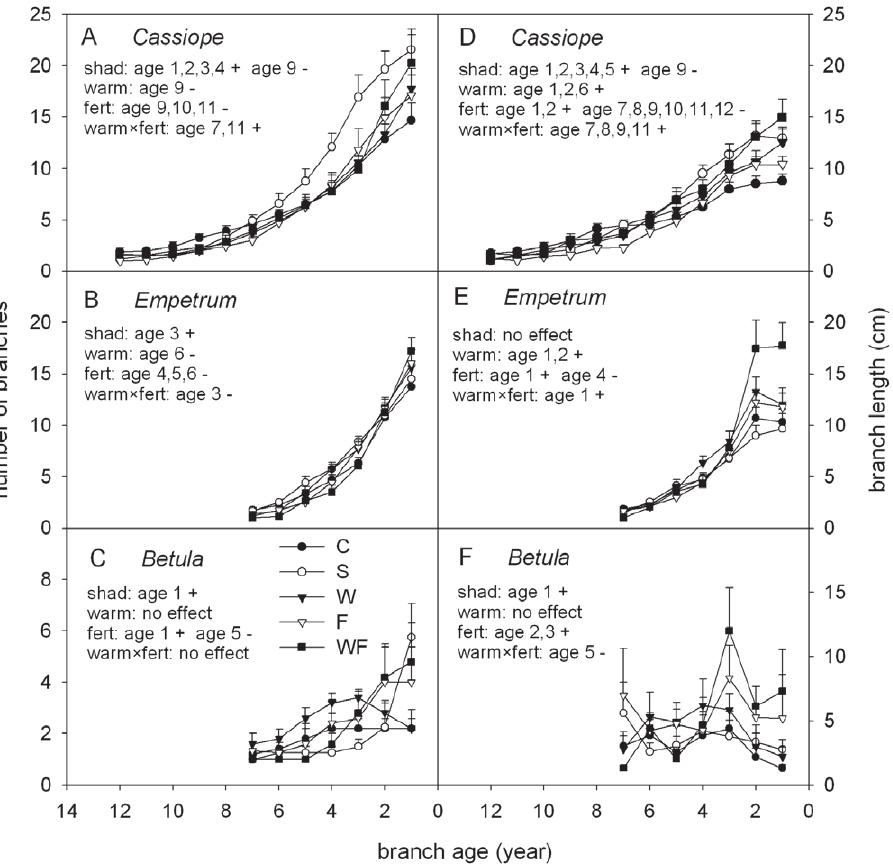
Figure 3. Branch number and length (according to age) of subarctic shrubs in manipulated environment. Number and length of the branches vs. branch age (means + 1SE; n=5–6) of the shrubs Cassiope tetragona , Empetrum hermaphroditum and Betula nana at a subarctic heath in Abisko (Northern Sweden) after 22 years of environmental manipulation. Text on the top left indicates the environmental factors with a significant impact (shad: shading; warm: warming; fert: fertilisation, and warm 6 fert: warming 6 fertilisation), their direction ( + : positive, 2 : negative) and the age of the branches affected. Note the different scale between y-axes of panel A,B,D,E and panel C,F.